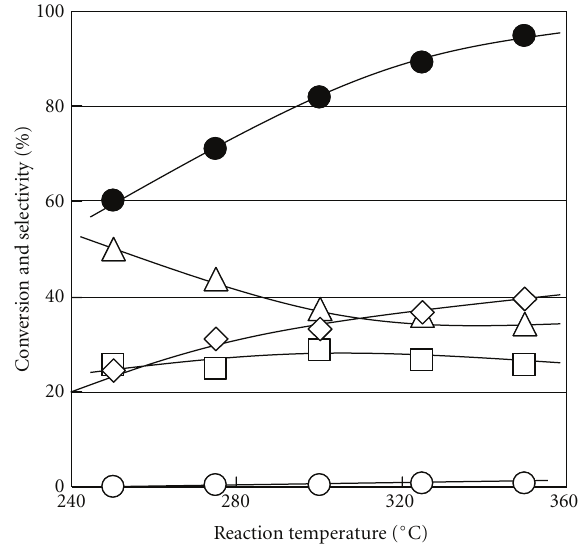
Figure 4: Conversion and pProduct selectivity of hydrocracking of nonhydrotreated oil over [NiMo/ γ -Al 2 O 3 ]/ ns Al 2 O 3 /H-beta zeolite catalyst depending on reaction temperature. (cid:2) : Conversion; (cid:2) : isopara ffi ns; (cid:2) : olefins; ♦ : selectivity: (cid:4) : normal para ffi ns; aromatics.